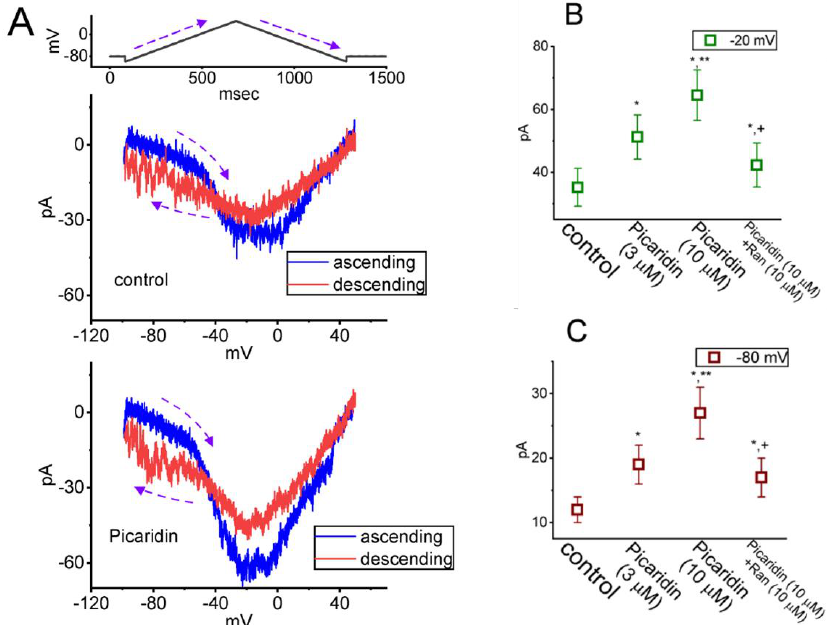
Figure 6. Modification by picaridin on voltage-dependent hysteresis (Hys (V) ) of persistent I Na (I N(P) ) elicited by an upright isosceles-triangular ramp voltage (V ramp ). The experiments were undertaken when the tested cell was voltage- clamped at −80 mV, and the V ramp from −100 to +50 mV for a duration of 1.2 s (i.e., ramp speed of ±0.25 mV/ms) was applied to it. ( A ) Exemplar current traces acquired during the control period (upper part) and in the presence of 10 μM picaridin (lower part ). The trajectory shown in blue or red color indicates current trace evoked at the ascending (up- sloping) or descending (down-sloping) limb of the upright triangular V ramp , respectively. The voltage protocol is illustrated atop current traces. The dashed curve arrows in each panel represent the direction of potential or current trajectory by which time goes. Summary graph showing the effects of picaridin (3 or 10 μM) and picaridin plus Ran on I Na(P) amplitude activated by the up- sloping (ascending), ( B ) or down-sloping (descending), ( C ) limb of 1.2-s triangular V ramp is, respectively, illustrated. The I Na(P) amplitude at the up-sloping or down-sloping end of V ramp was measured at −20 or −80 mV, respectively. Each point indicates the mean ± SEM (n = 8). * Significantly different from control ( p < 0.05), ** Significantly different from picaridin (3 μM) alone group ( p < 0.05), and + Significantly different from picari din (10 μM) alone group ( p < 0.05).